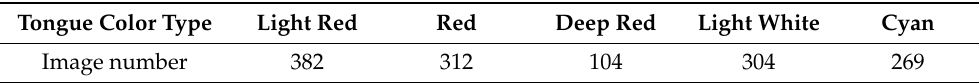
Table 1. Sample image data statistics.